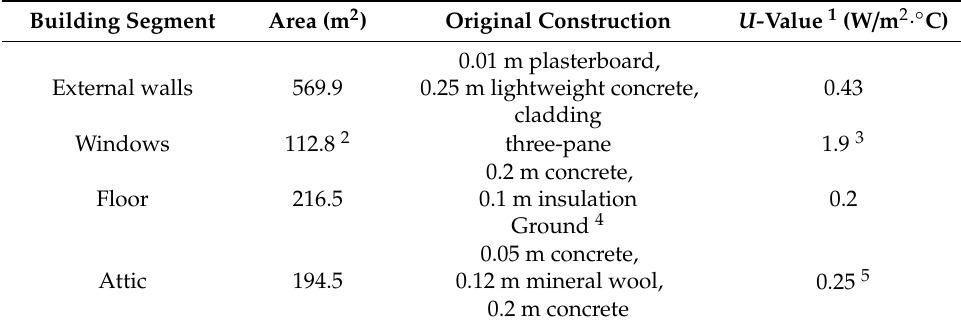
Table 2. Description of the reference building.